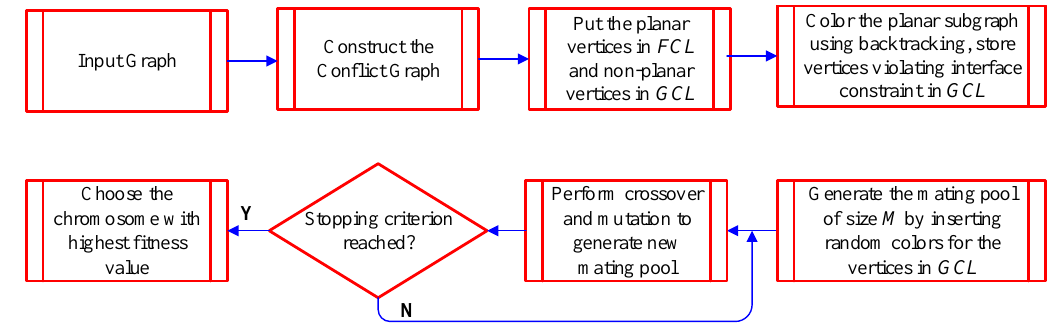
Figure 8. Joint route and channel assignment (JRCA) scheme.